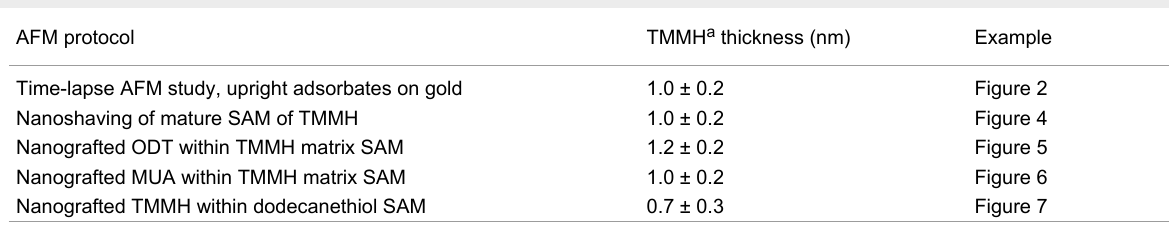
Table 1: Thickness measurements of TMMH on gold